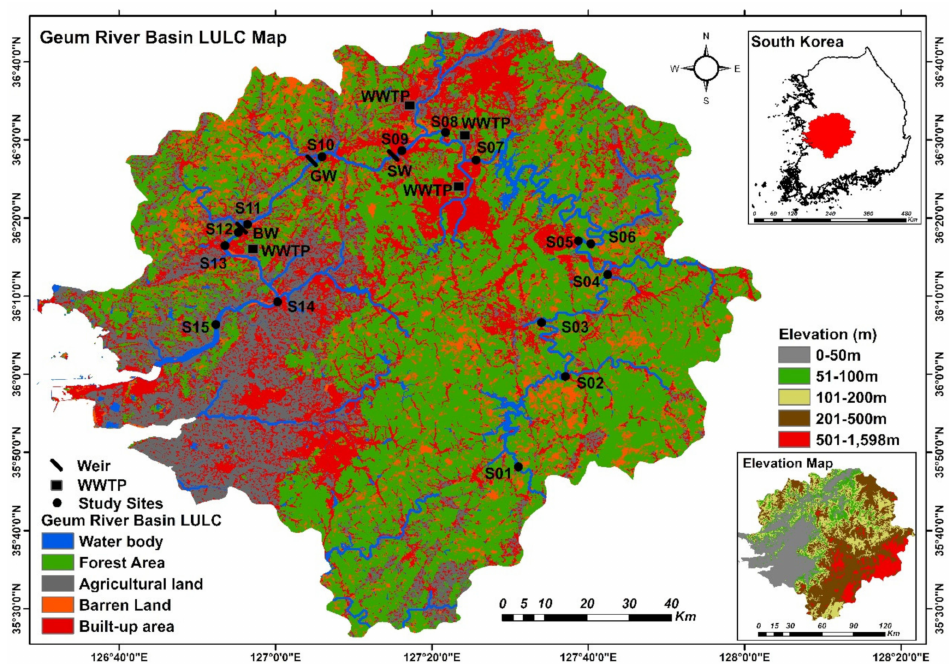
Figure 1. Map showing the sampling sites in the mainstream of the Geum River. SW, Sejong Weir; GW, Gongju Weir; BW, Baekje Weir; WWTP, wastewater treatment